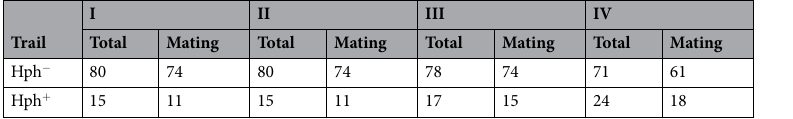
Table 2. Ratio of mfa2 complementation and Hph disruption * . * Transformants were all nourseothricin resistant and numbers were transformants obtained in each